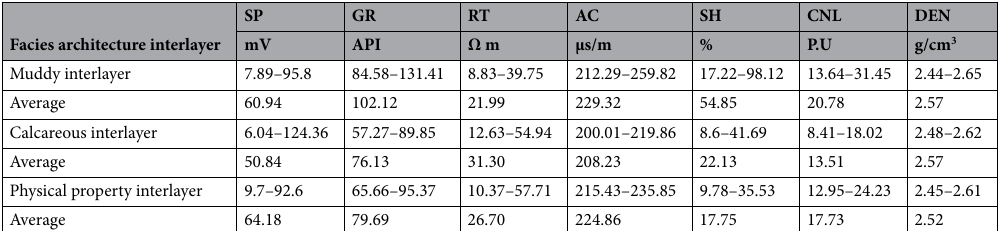
Table 3. Electric identification parameters of facies architectural